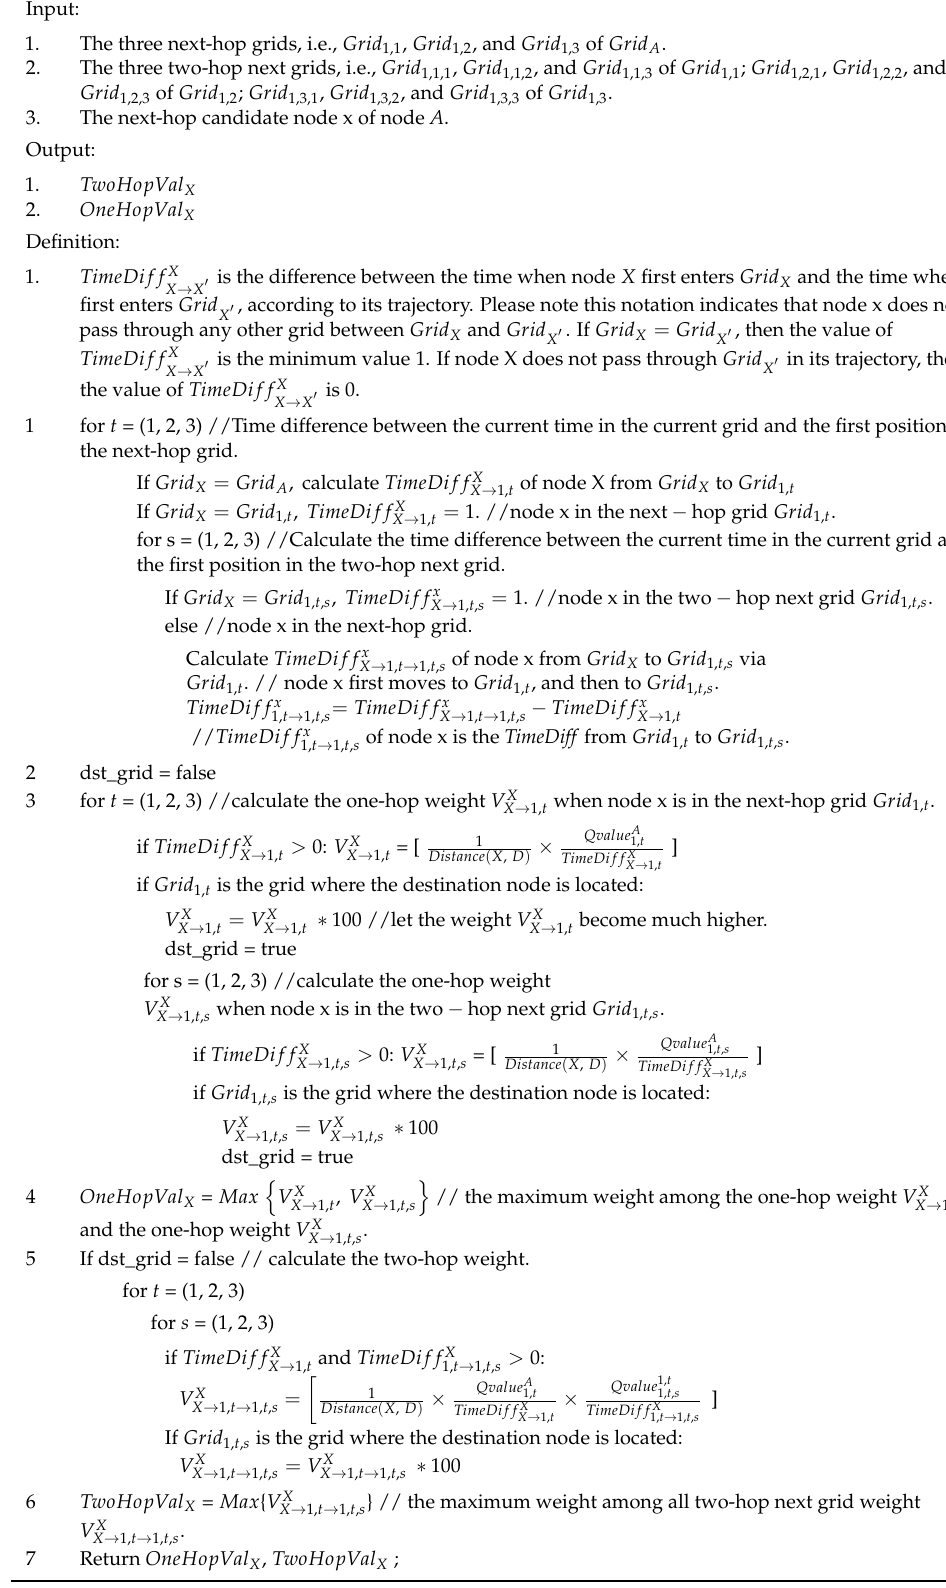
Algorithm 2. One-Two-Hop Value (Node A, Node